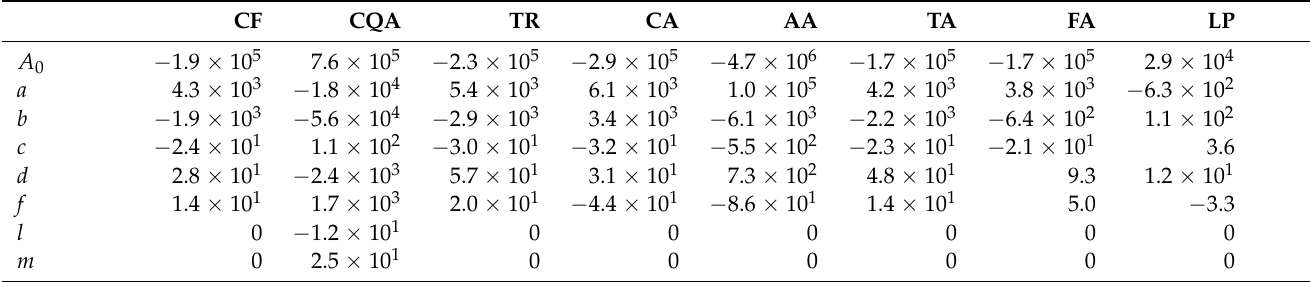
Table A2. Coefficients of the dissolution rate α r , v coarse granulometry r = C and Arabica variety v = A.